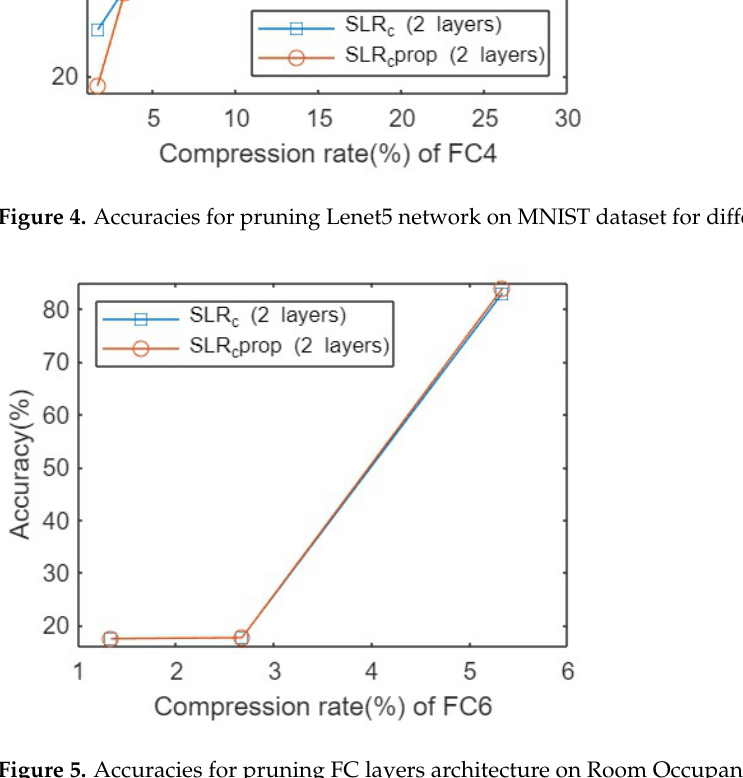
Figure 5. Accuracies for pruning FC layers architecture on Room Occupancy Detection dataset for different compression rates.